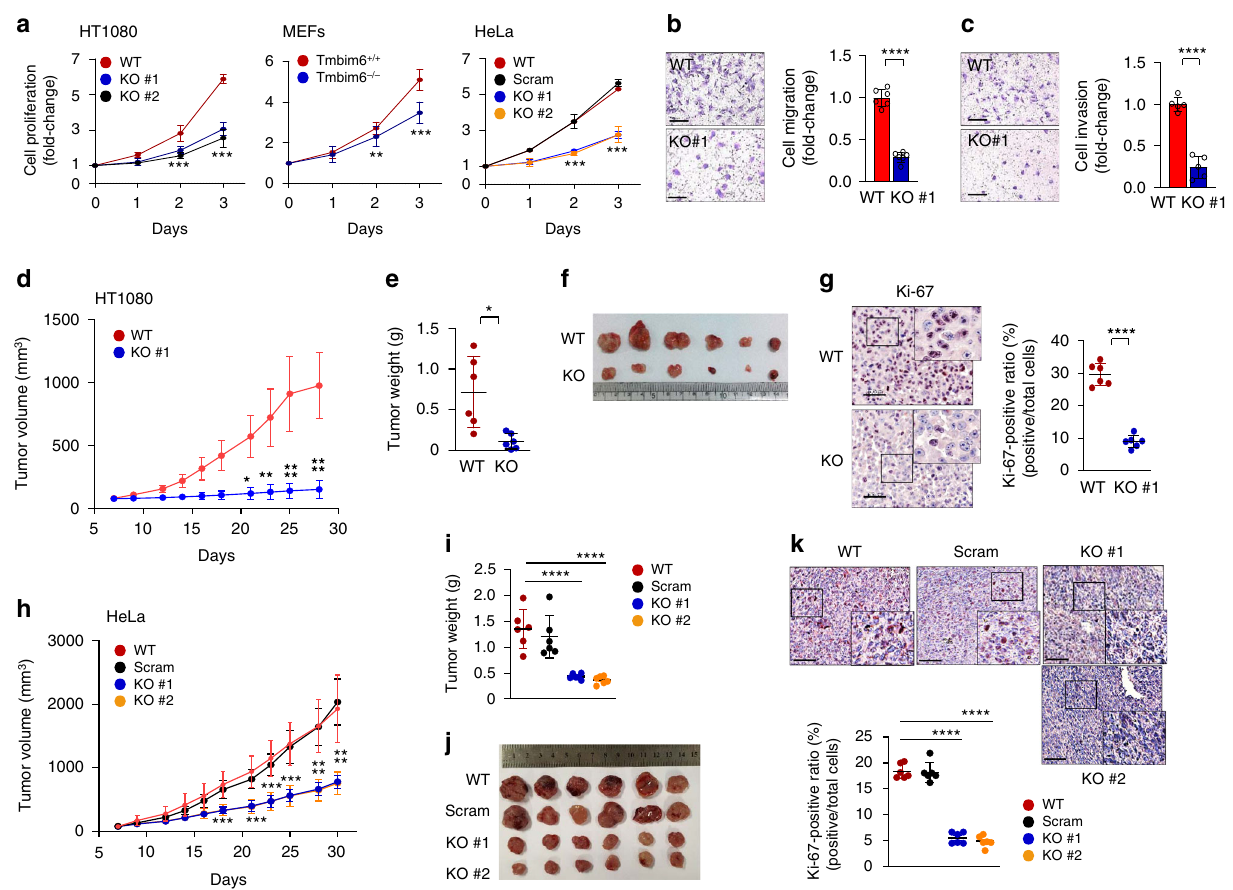
Fig. 2 TMBIM6 enhances tumor growth. a Proliferation of TMBIM6 KO and WT HT1080 cells, HeLa cells, and MEFs ( n = 3 independent experiments). Data are presented as means ± SD. ** p < 0.01, *** p < 0.001, two-way ANOVA followed by Bonferroni ’ s post hoc test. b Images of migrated cells in TMBIM6 KO and WT HT1080. Right, quanti fi cation of WT cells normalized to KO cells ( n = 6 independent experiments). Scale bars, 100 μ m. Data are presented as means ± SD. **** p < 0.0001, two-tailed unpaired t -test. c Images of invasive cells in TMBIM6 KO and WT HT1080. Right, quanti fi cation of WT cells normalized to KO cells ( n = 5 independent experiments). Scale bars, 100 μ m. Data are presented as means± SD. **** p < 0.001, two-tailed unpaired t -test. d – f Tumor volume, weight, and size derived from TMBIM6 KO or WT HT1080 cells injected into the fl ank of 6-week-old nude mice ( n = 6 mice per